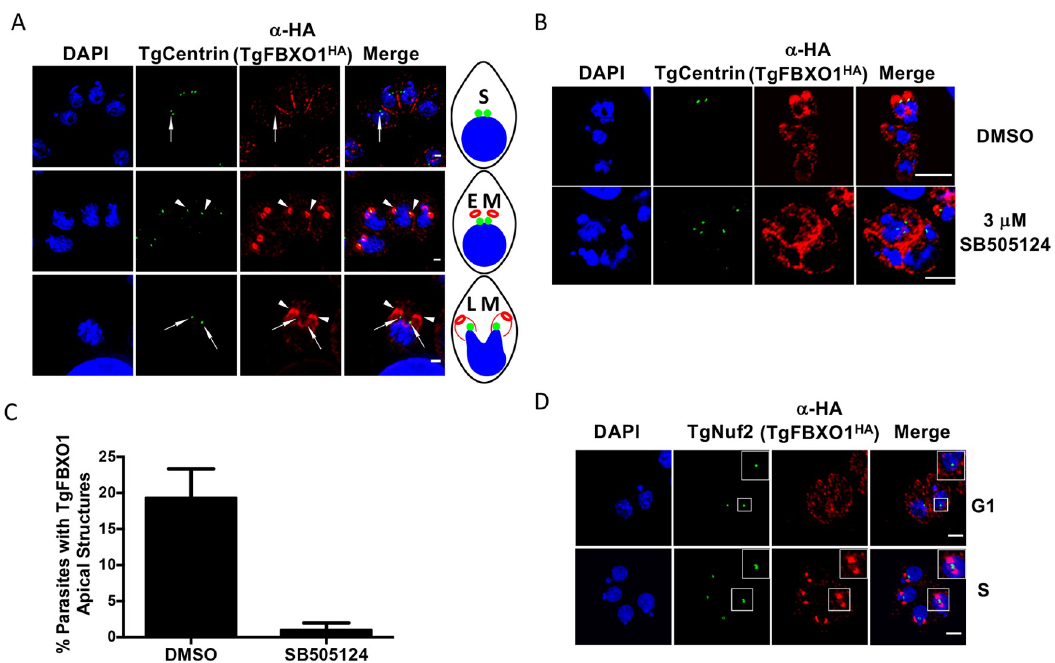
Fig 4. TgFBXO1 apical structures form after centrosome duplication and are localized apically to the parasite centrosome. (A) . TgFBXO1 HA -expressing parasites were fixed and stained to detect TgCentrin1, TgFBXO1, and DNA during S, early M (EM), and late M (LM) phases. Arrowheads highlight TgFBXO1 apical structures and arrows highlight TgCentrin1. Bars = 2 μ m.A schematic depicting the cell cycle phases is shown. (B) . Parasites were treated with 3 μ M SB505124 (or DMSO as a vehicle control) for 24 h, fixed and then stained to detect TgCentrin1, TgFBXO1, and DNA. Note the appearance of SB505124-treated parasites with > 2 centrin1 + foci and disorganized TgFBXO1 staining. Bars = 5 μ m. (C) . Quantification of numbers of parasites with apical TgFBXO1 structures. Data represents averages and standard deviations of three independent experiments with at least 50 parasites examined/experiment (D) . TgFBXO1 HA parasites were stained to detect TgFBXO1 and the kinetochore marker TgNuf2. Note TgFBXO1 HA apical structures form after kinetochore duplication but before separation is completed as evidenced by the lobed TgNuf2 staining (Insert). Bars: 2 μ m.